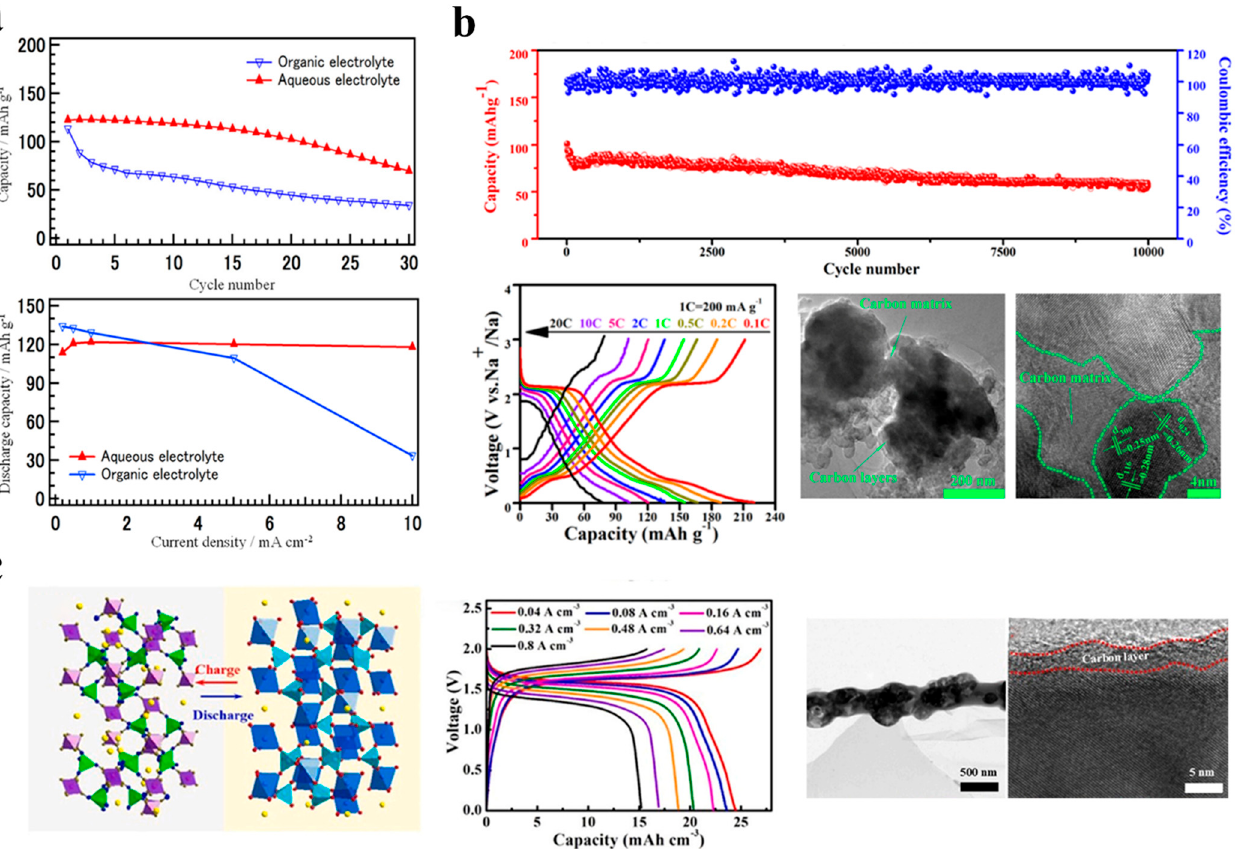
Figure 8. ( a ) Comparison of electrochemical performance for carbothermally treated NaTi 2 (PO 4 ) 3 in aqueous electrolyte and organic electrolyte. Reproduced with the permission of ref. [30], copyright 2011 The Electrochemical Society. ( b ) Physicochemical characterization and battery performance of